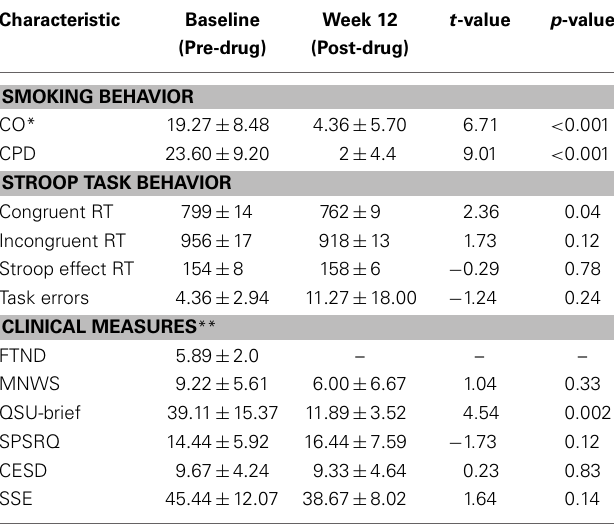
Table 1 | Study Completers: Behavioral and Clinical Measures.